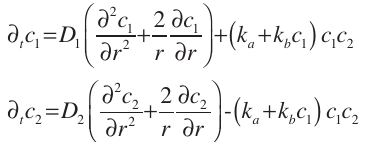
Figure 1 Coexisting non-uniform stable steady profi les of c = 0.0375 cm, D = 2 × 10 -5 cm 2 /s, c a spherical gel. R sphere